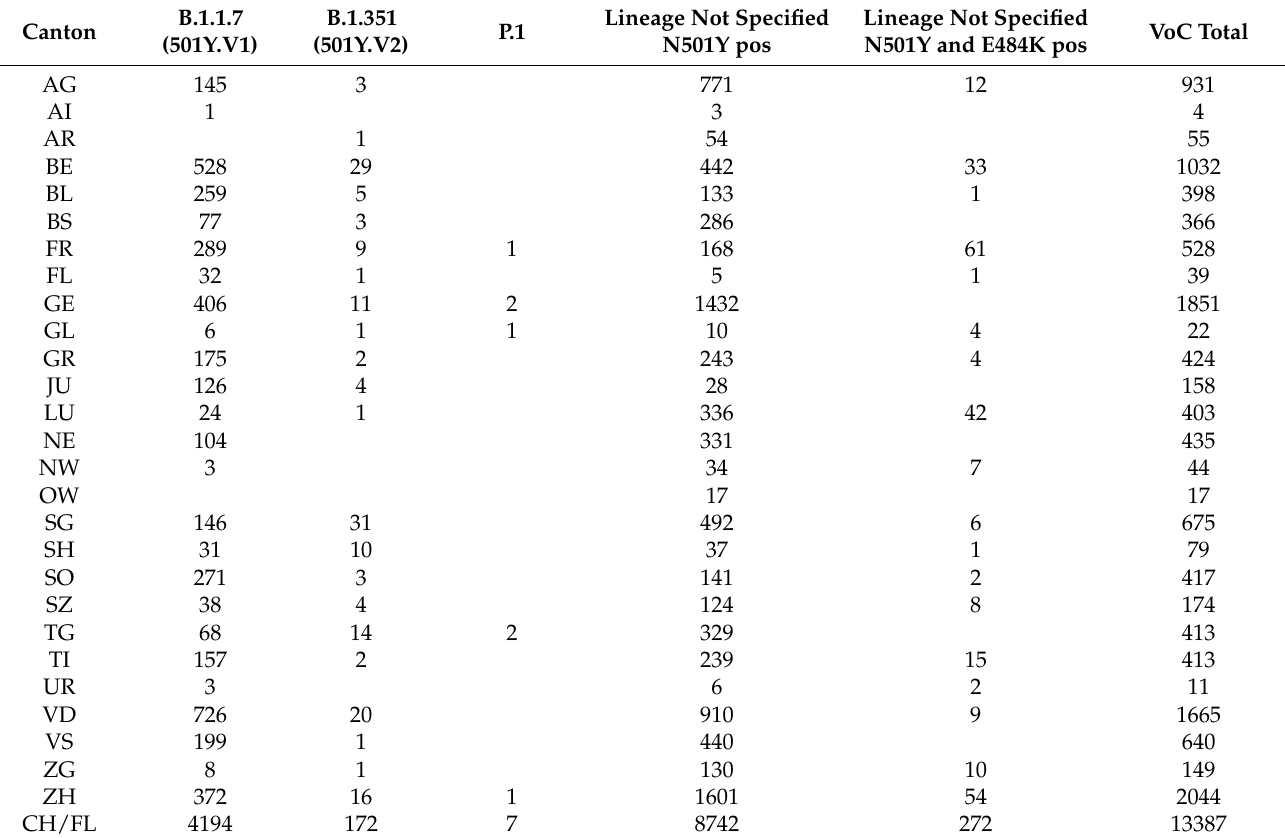
Table 1. Absolute numbers of variants of concern (VoC) including cases of B.1.1.7, B.1.351, and P.1 in Switzerland and Principality of Liechtenstein. Absolute numbers reflect a biased sample set due to the initial case definitions and biased distribution of diagnostic capacities. The numbers and distributions of lineages is likely biased due to delay in processing and different sequencing capacities. Cantons: AG, Aargau; AI, Appenzell Innerrhoden; AR, Appenzell Ausserrhoden; BE, Bern; BL, Basellandschaft; BS, Basel-Stadt; FR, Fribourg; FL, Fürstentum Lichtenstein; GE, Geneva; GL, Glarus;